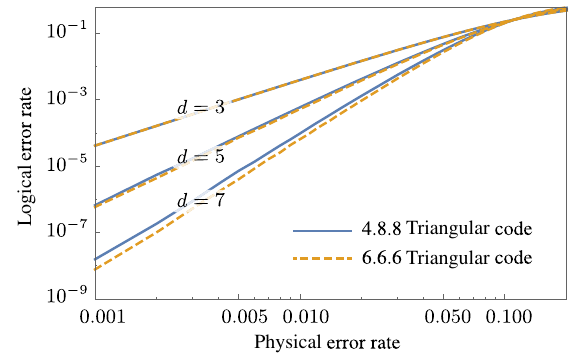
FIG. 24. Logical error rate of the first three 4.8.8 and 6.6.6 triangular color codes. Even though the codes have the same code distance and error threshold, 4.8.8 color codes have a higher logical error rate but require fewer physical qubits per logical